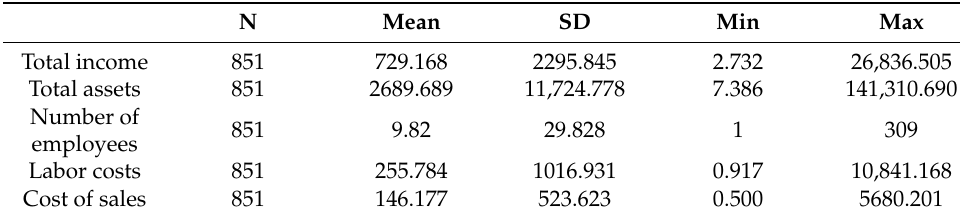
Table 1. Cultural tourism: descriptive statistics.